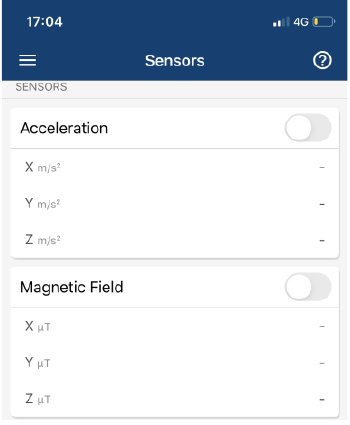
Figure 34. Collecting data from sensors embedded in smartphones: ( a ) data collected from a mobile phone’s accelerometer; ( b ) data collected from a mobile phone’s angular velocity (gyroscope).